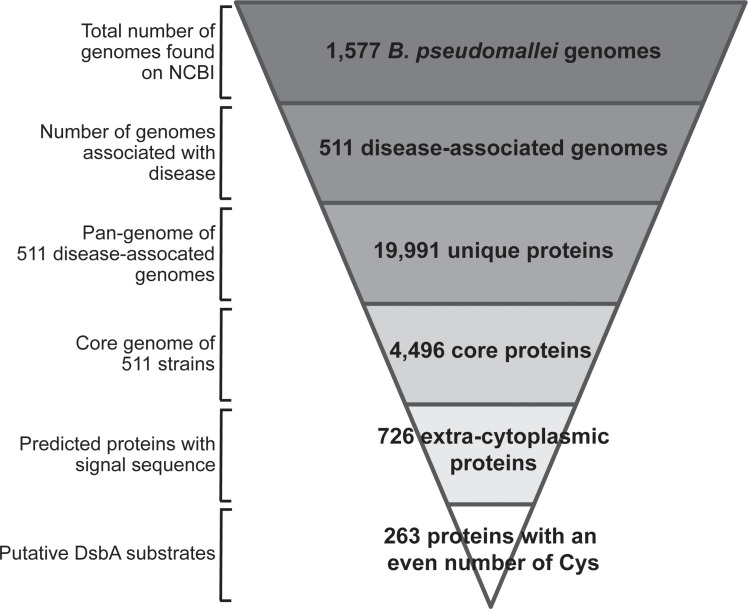
Bioinformatic workflow.From the 1,577 B. pseudomallei genomes found on NCBI, 511 were unique and associated with disease and these were used for further analysis. The pangenome of these 511 genomes comprised 19,991 unique genes. 4,496 of these were classified as core genes. Predicted translation of these genes gave 726 predicted extra-cytoplasmic proteins. Of these extra-cytoplasmic proteins, 263 were predicted to contain an even number of cysteines. We predict that these 263 proteins are substrates of B. pseudomallei DsbA.